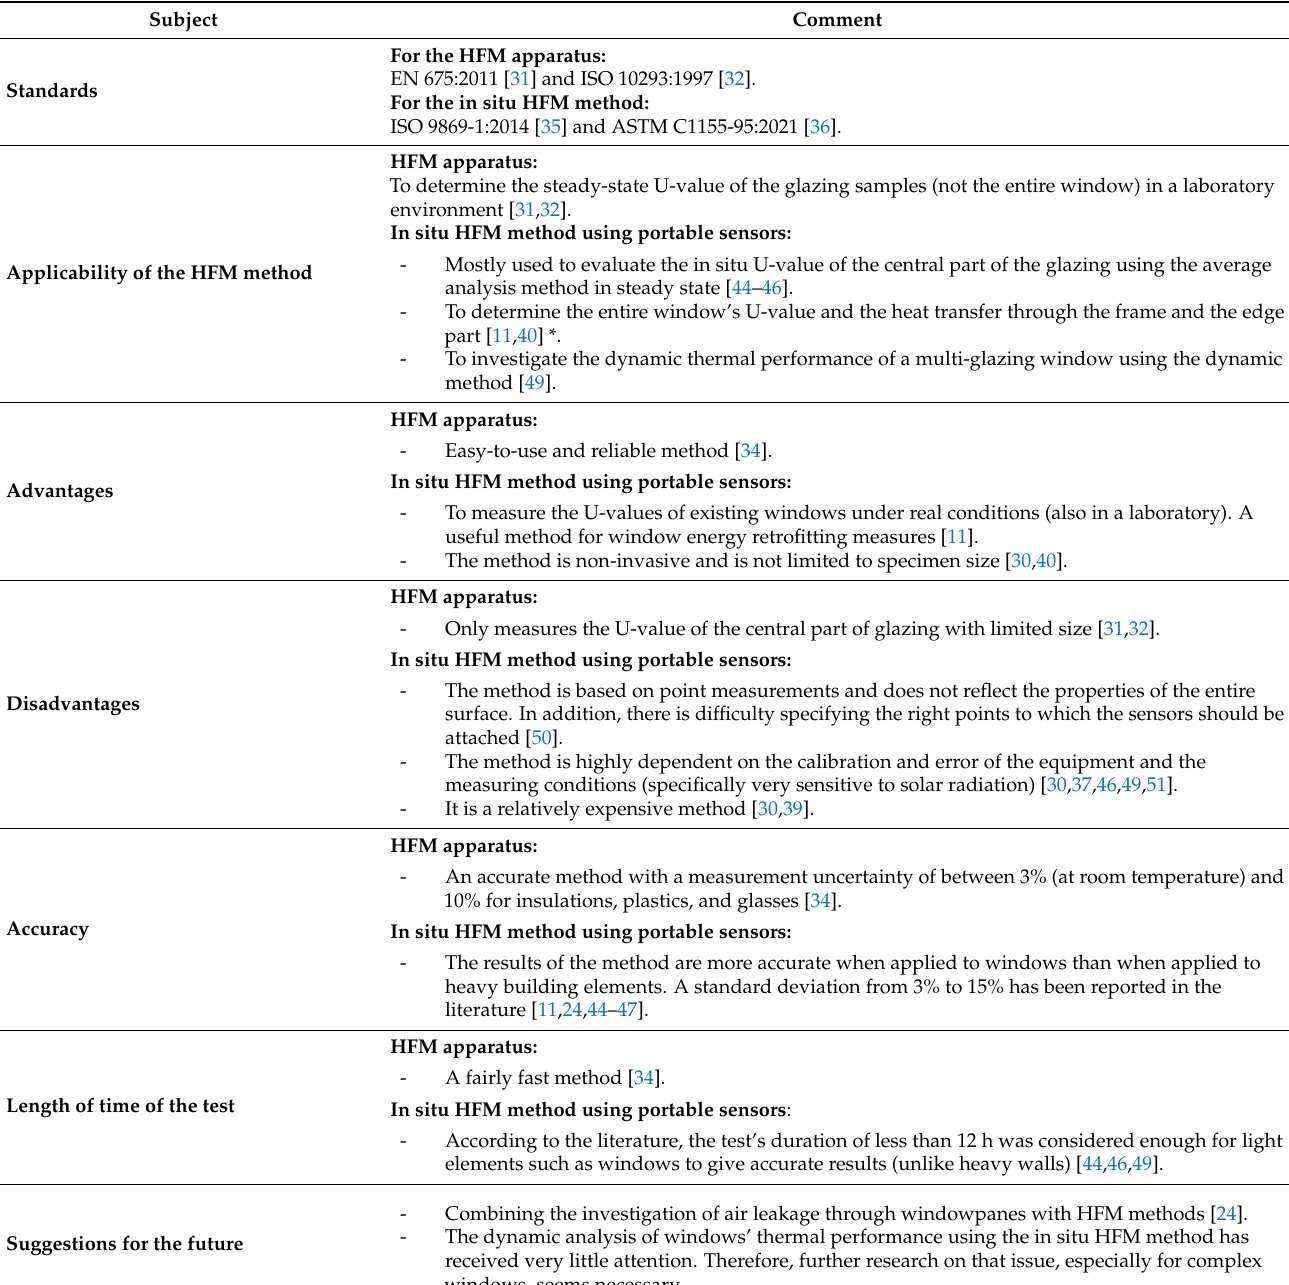
Table 1. Summary of the HFM method with a focus on glazing